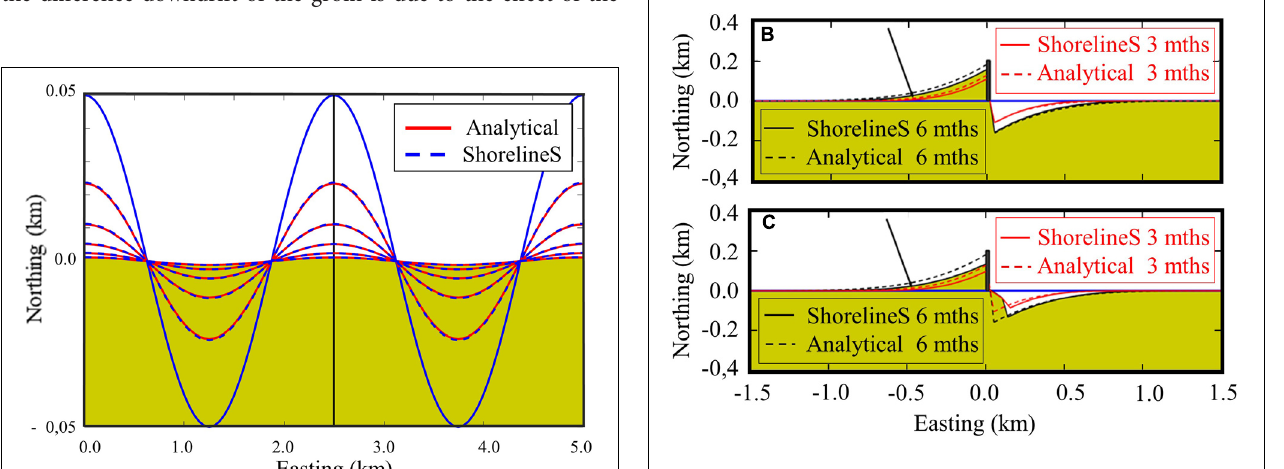
FIGURE 5 | Shoreline response for both the analytical solution and ShorelineS with different wave angles and bypassing approaches. Panel A: incident angle 10 ◦ , no shadowing; panel B: incident angle 25 ◦ , no shadowing; panel C: incident angle 25 ◦ , with partial bypassing and